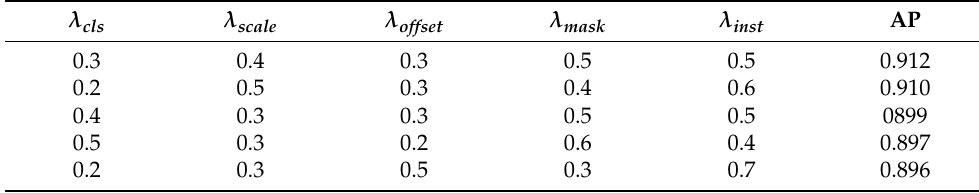
Table 1. Performance Comparison of Loss Function